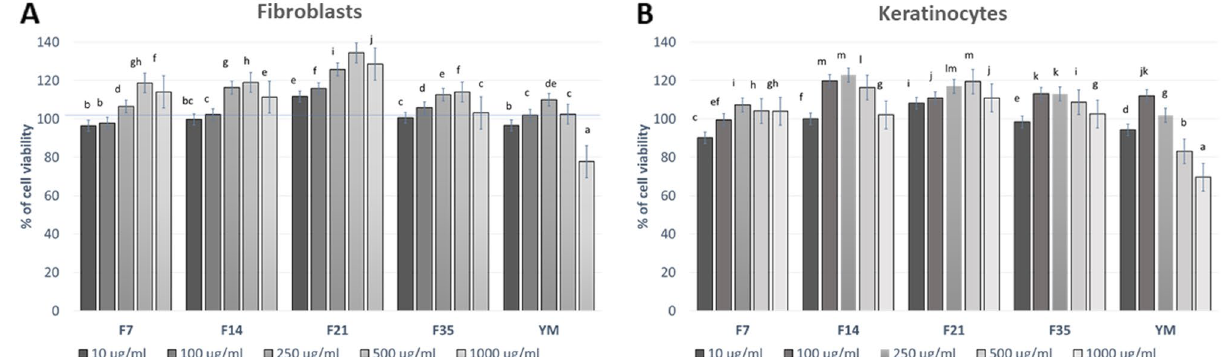
Figure 6. Effect of the increase in the concentration of extract and ferments (10–1000 μg/mL) on cell viability (Neutral Red assay) by cultured fibroblasts ( A ) and keratinocytes ( B ) after 24 h exposure. Data are the mean ± SD of three independent experiments each consisting of three replicates per test group. Different letters on the charts indicate significant differences between groups ( p < 0.05).